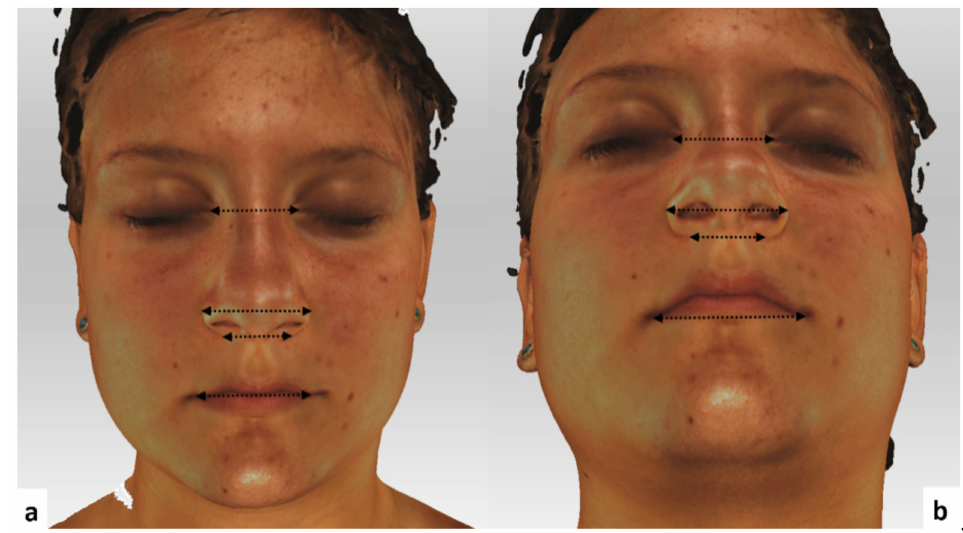
Figure 3. Linear measurements used in our study. ( a ) Frontal view. ( b ) Base view.